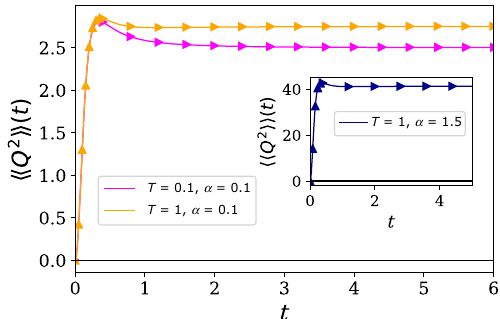
FIG. 1. Mean heat dissipated into the bath as a function of time in the independent-boson model, as given by Eq. (45) (triangles) and as calculated numerically (solid lines), for four different val- ues of the coupling strength α . The spin splitting is ω 0 = 1, the temperature is T = 5, and the bath cutoff is ω C = 5. The param- eters controlling the numerical accuracy are K (cid:6) = 5, (cid:6) = 0.01, and p = 100, and the derivative is taken at u = 0.01.